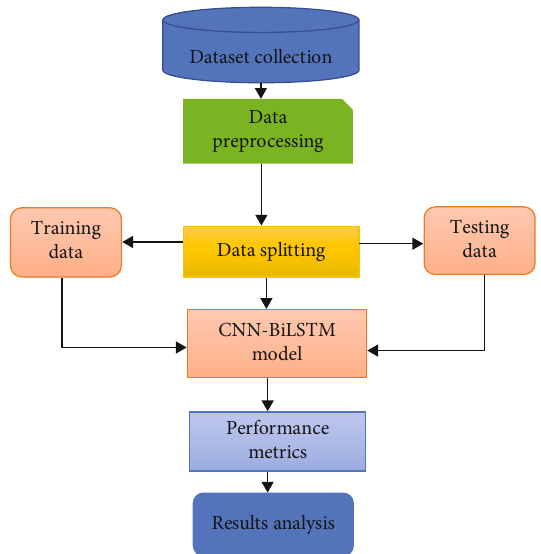
Figure 1: Work fl ow of the used